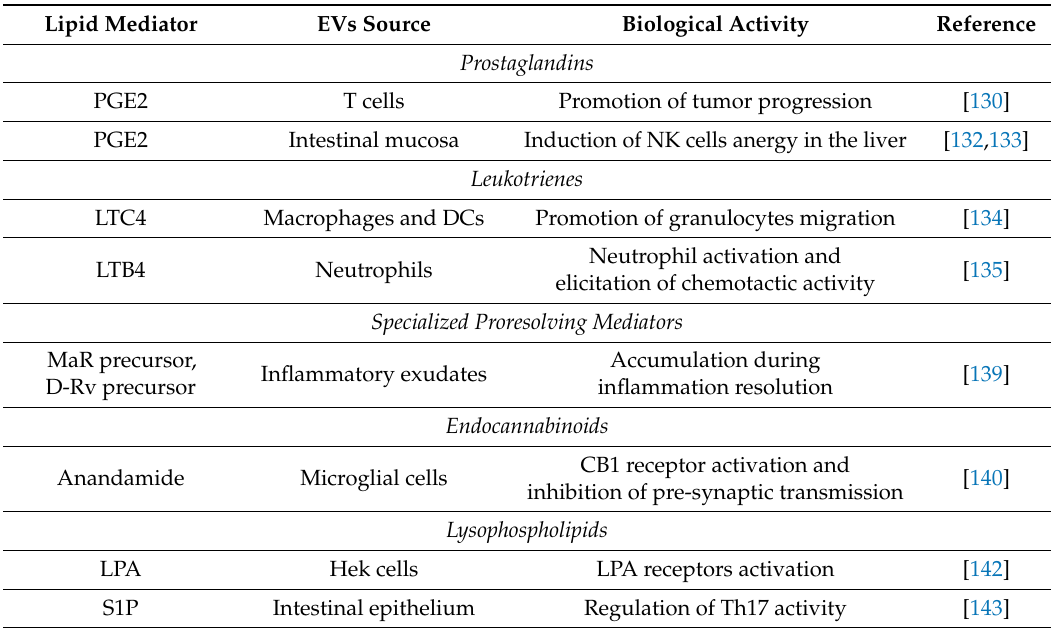
Table 1. Summary of the studies reporting not only the presence but also a biological role for lipid mediators carried by extracellular vesicles (EVs). DC: dendritic cells; MAR: maresins; LPA: lysophosphatidic acid, S1P: sphingosine